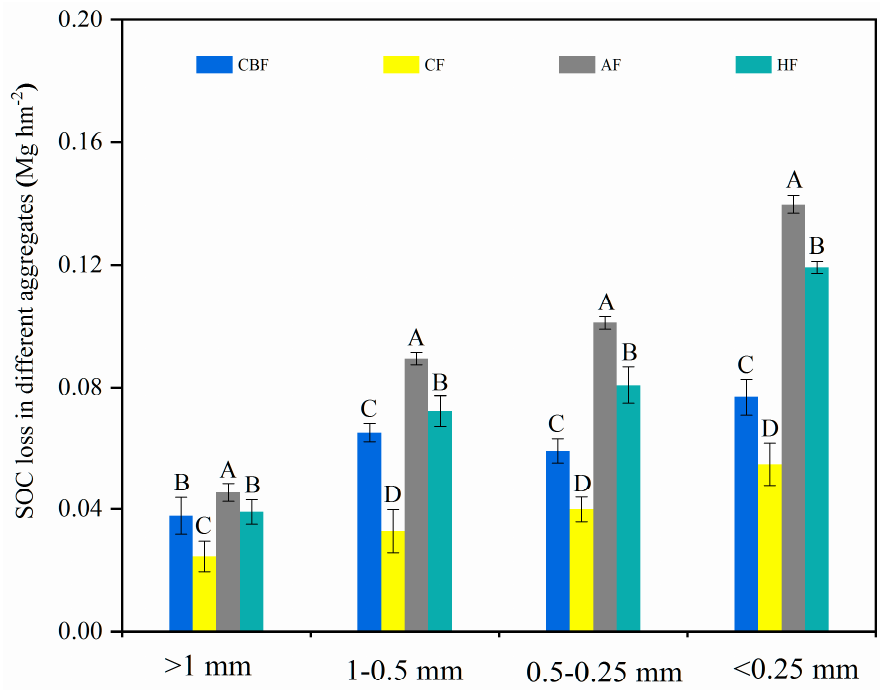
Figure 4. SOC loss for each aggregate fraction of the different forest types. Note: The different capital letters indicate significant differences in the same aggregate size among different forest types ( p < 0.05). Values are means ± standard errors.